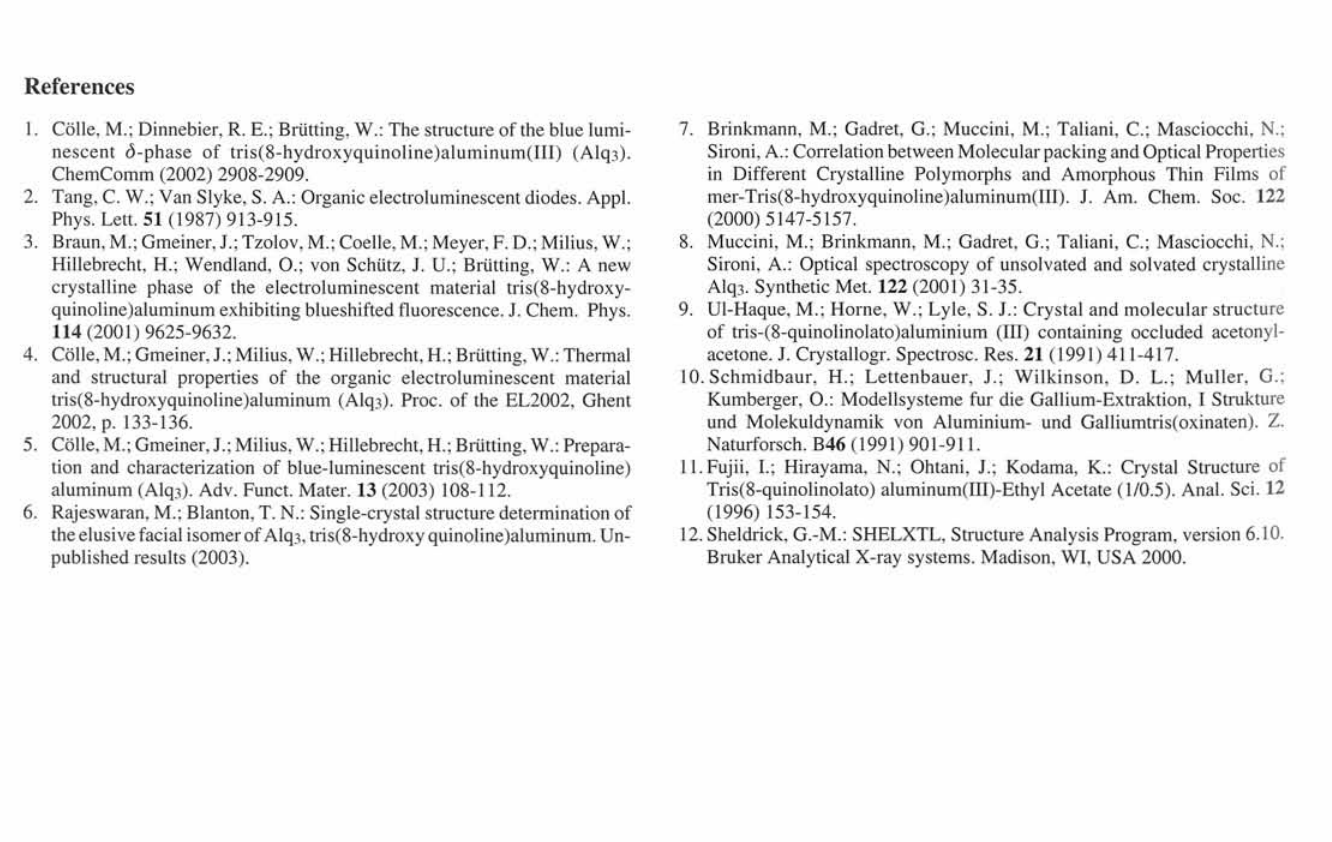
Table 2. Atomic coordinates and displacement parameters (in Â 2